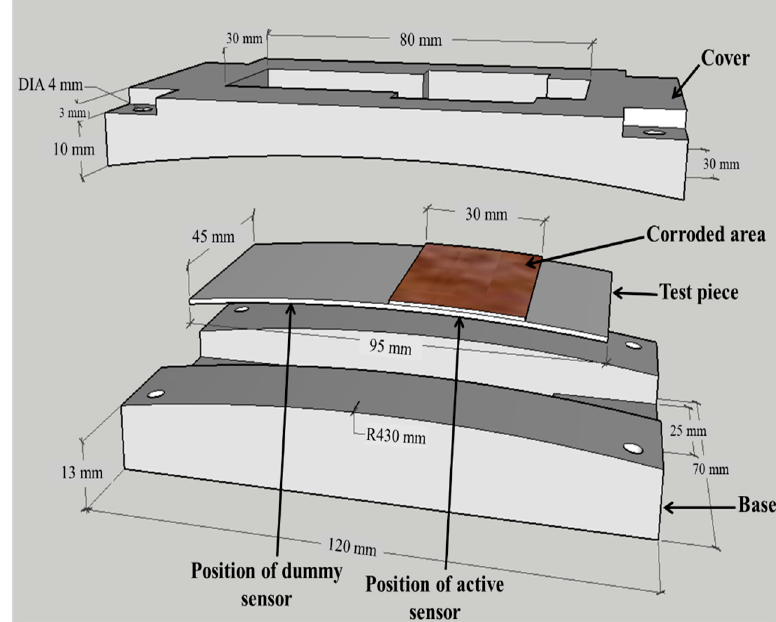
Figure 2. Diagram of the atmospheric corrosion sensor based on strain measurement (ACSSM) apparatus, consisting of a base, the test piece, and a cover.